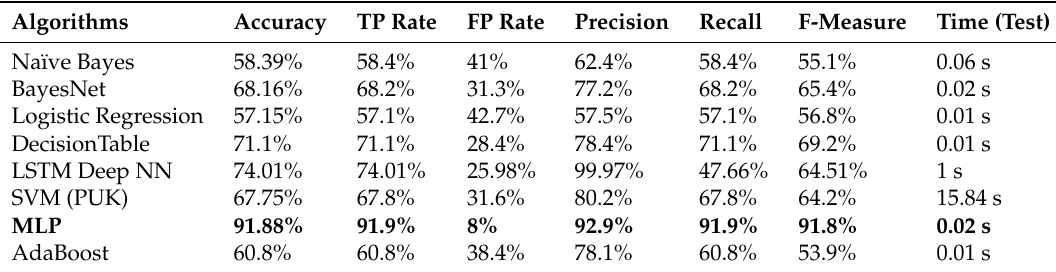
Table 8. Performance evaluation for attack scenario